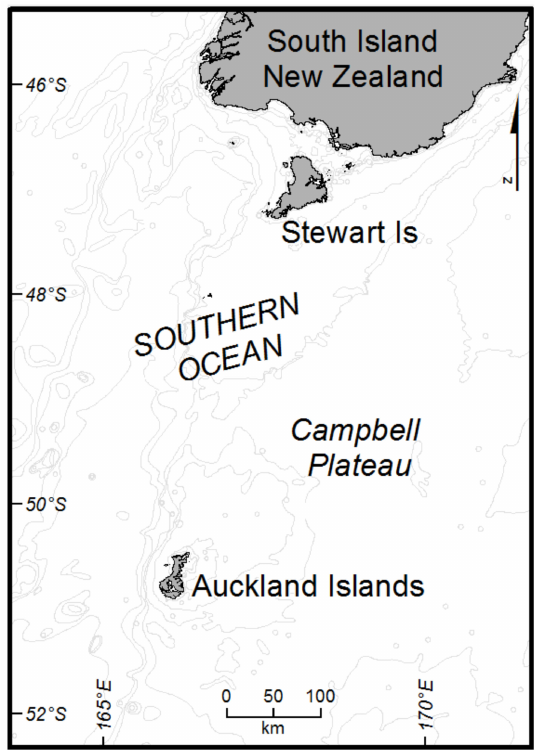
Figure 1. Auckland Islands